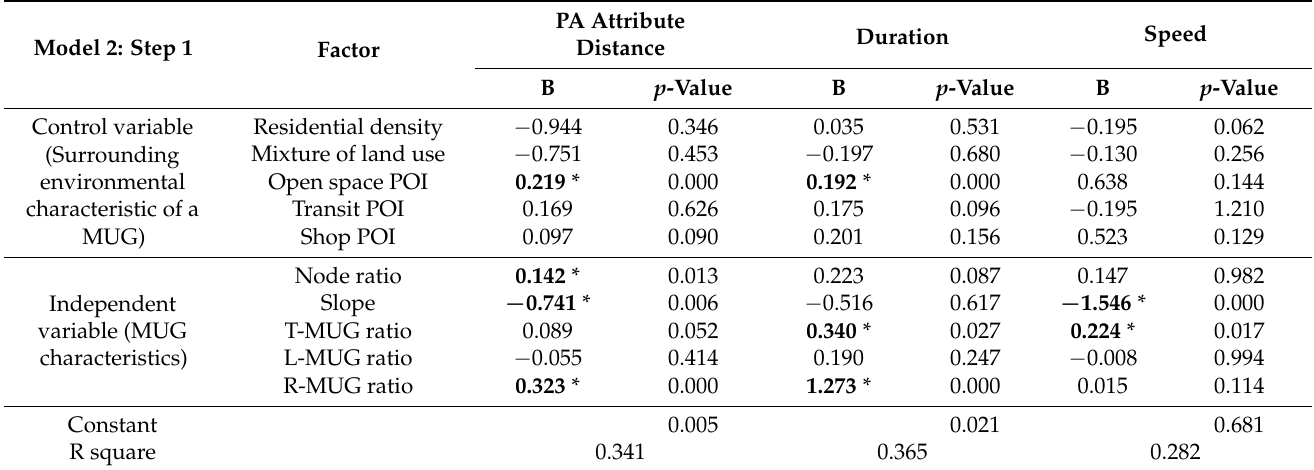
Table 8. Linear regression model of PA attributes: Step